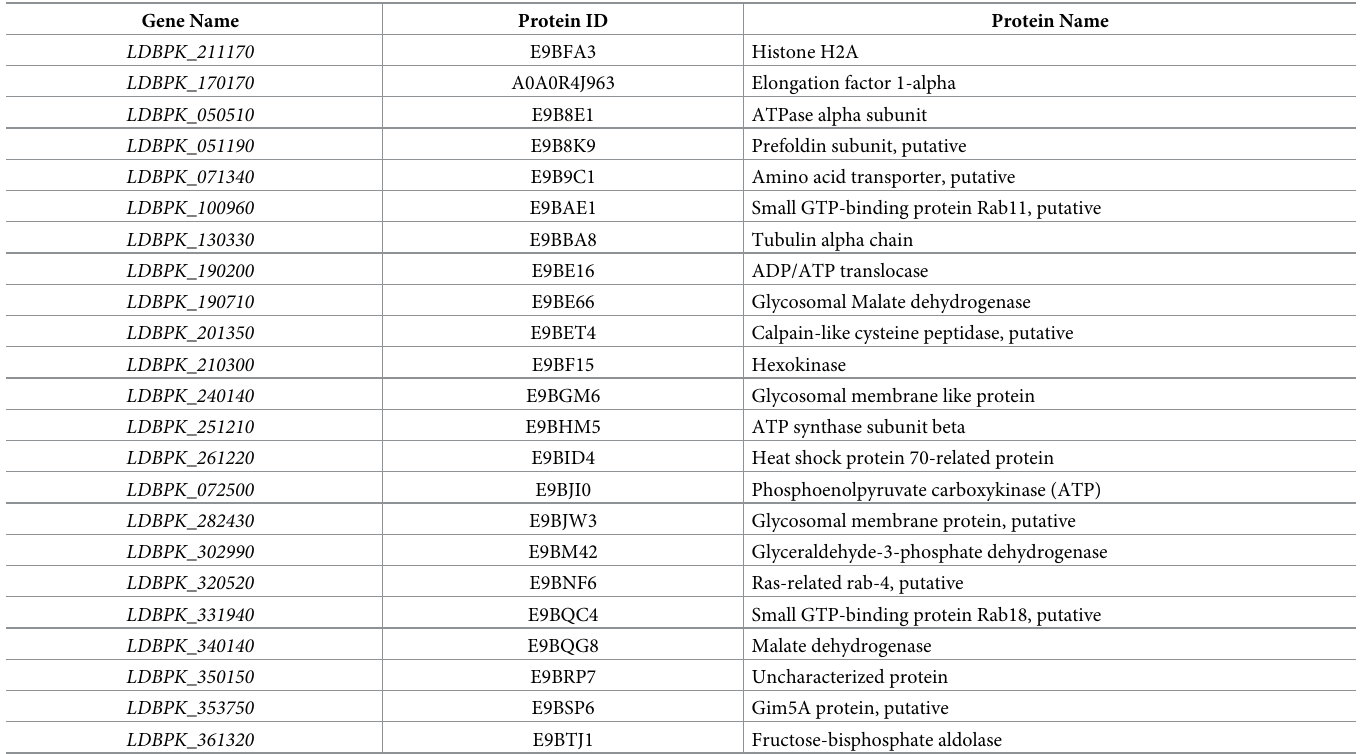
Table 1. Leishmania proteins associated with host-cell